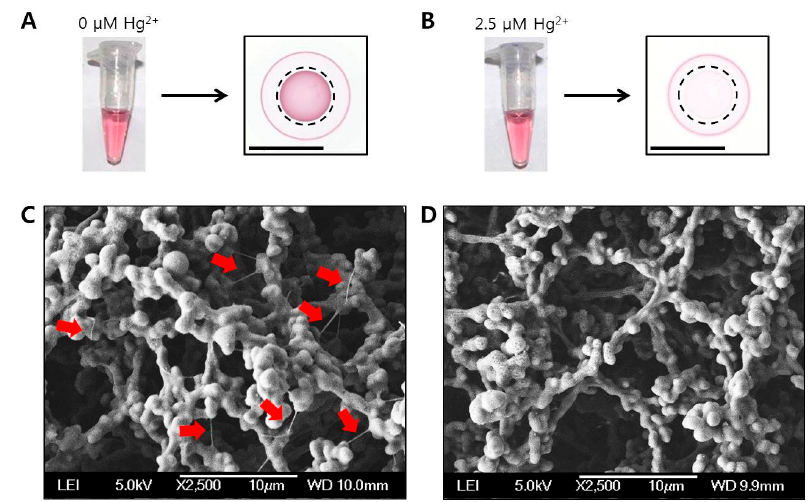
Figure 4. RCA reaction solution in the tube (left) or drop-dried on the paper (right): in the absence of Hg 2+ ( A ); or in the presence of 2.5 µM Hg 2+ ( B ). Dotted circles in Figure 4A,B indicate the areas for measuring color intensities using a portable spectrophotometer. The length of the inset scale bars in Figure 4A,B are 10 mm. Scanning electron microscopy (SEM) images of two different papers prepared by drop-drying of the RCA reaction solution: in the absence of Hg 2+ ( C ); or in the presence of 2.5 µM Hg 2+ ( D ). Red arrows in the SEM image indicate DNA coil-AuNP complexes. The length of the inset scale bars in Figure 4C,D are 10 µ